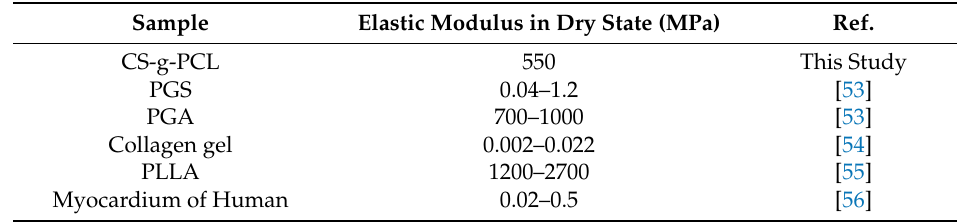
Table 3. Young’s modulus values of the tested samples and biomaterials used in myocardium